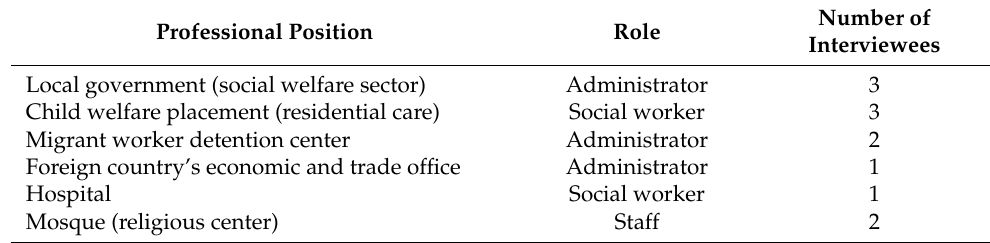
Table 1. Interviewee